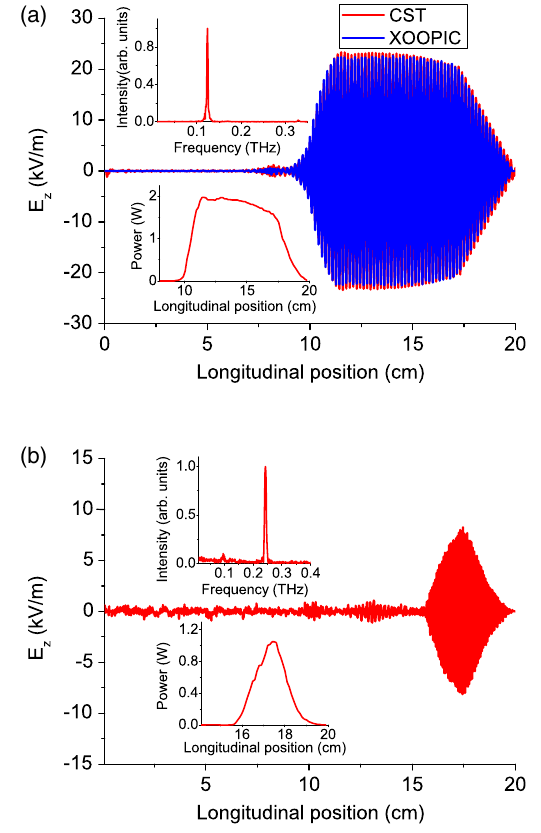
FIG. 5. Simulated electric field strength at r ¼ 0 . 40 mm, the corresponding spectrum calculated by Fourier trans- form, and the pulse power distribution along the longitu- dinal position. (a) The coherence factor is resonant at TM 01 ¼ 8 . 09 ps) and the beam energy is mode ( Δ τ ¼ 1 0 . 1236 THz 200 keV; (b) The coherence factor is resonant at TM 01 mode ( Δ τ ¼ 1 · 2 ¼ 8 . 2 ps) and the beam energy is 0 . 2434 THz 100